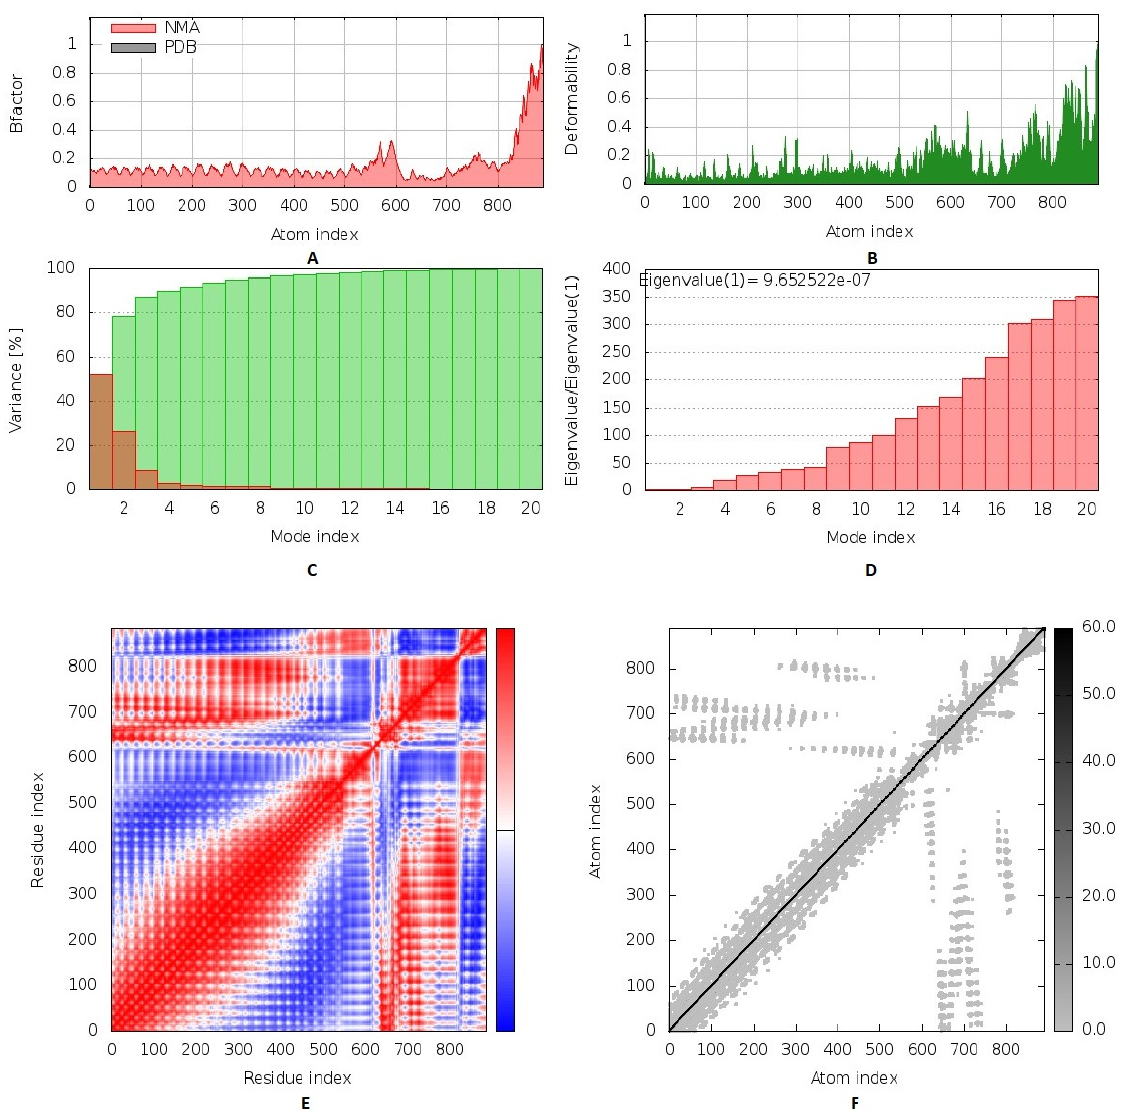
Figure 8. Inherited flexibility analysis of the predicted vaccine–TLR2 complex using normal mode analysis within dihedral coordinates. Complex mobility and flexibility were assessed through ( A ) B-factor values, ( B ) deformability, ( C ) variance, ( D ) eigenvalue, ( E ) covariance of residue index, and ( F ) elastic network analysis.